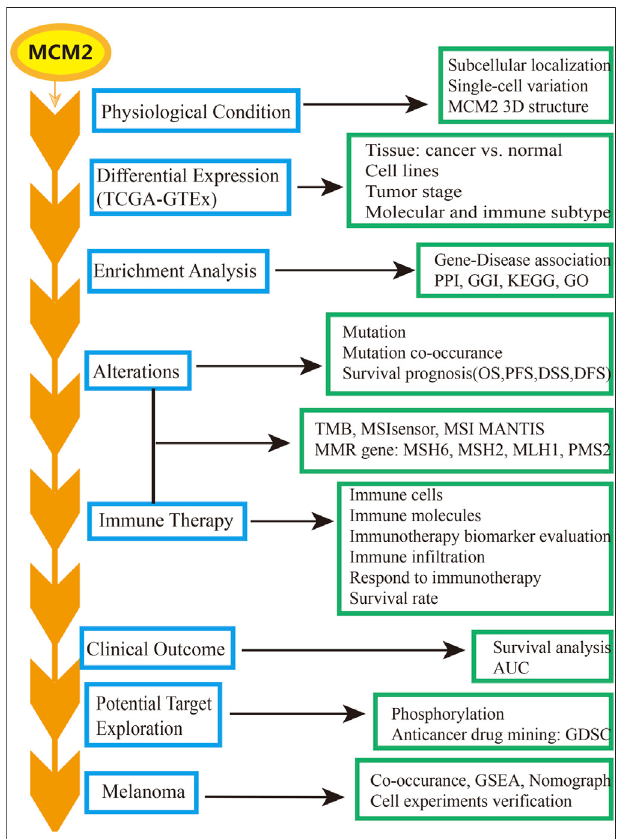
FIGURE 1 | The work fl ow of the